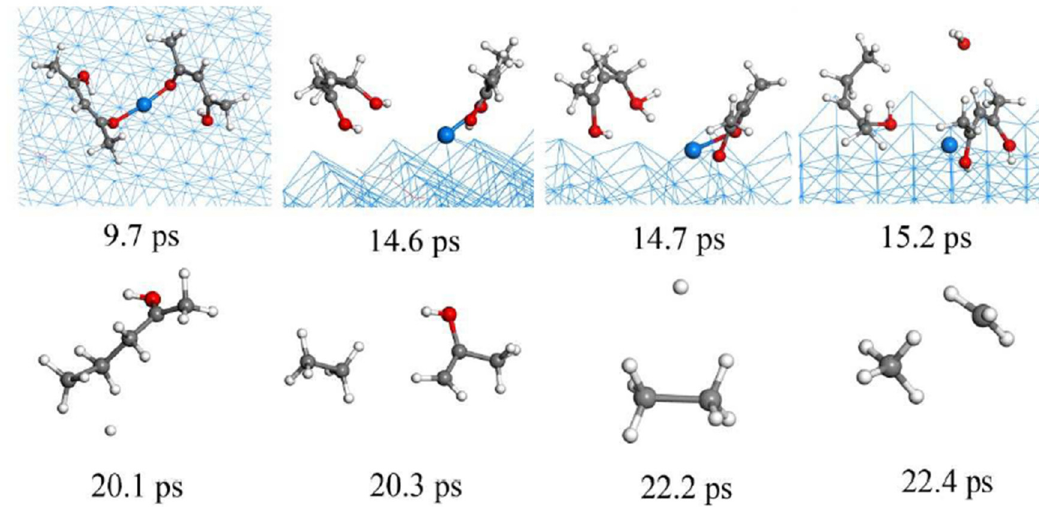
Figure 17: Reactive MD snapshots for the reaction between copper ( II ) acetylacetonate and hydrogen atoms on the copper ( 110 ) surface [ 154 ] .